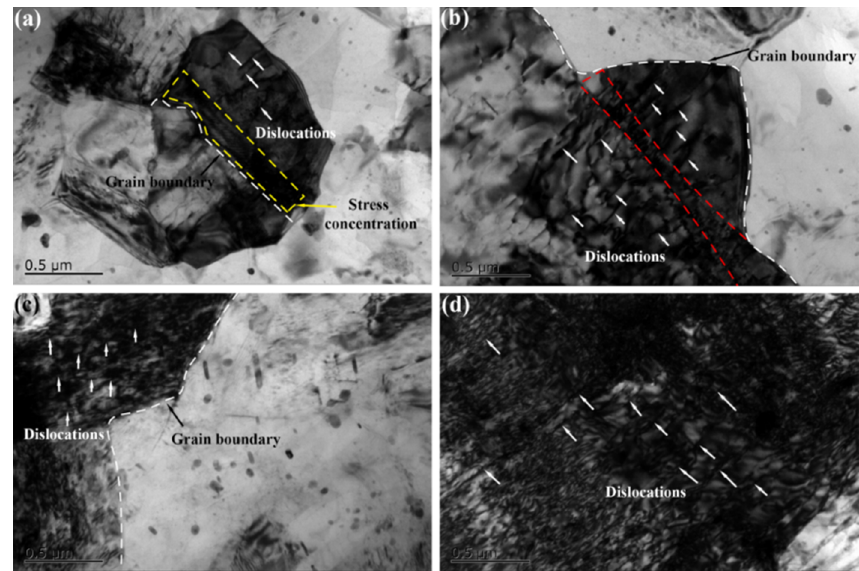
Figure 10. TEM images of as-extruded 0.05 wt.% ND/ZK60 composite under varied strains at the deformation temperature of 200 °C and strain rate of 1 s −1 : ( a ) 0, ( b ) 10%, ( c ) 30%, and ( d ) 40%.